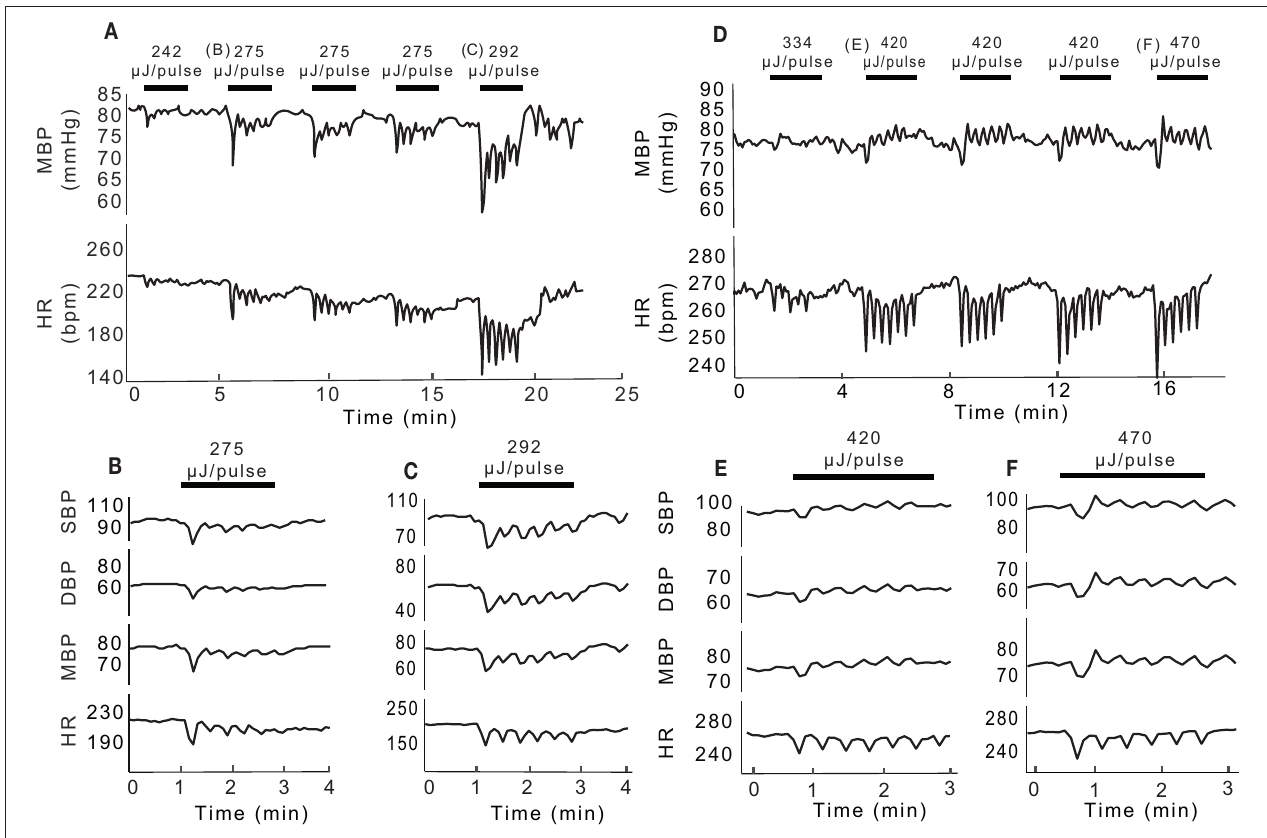
FIGURE 2 | Changes in BP and HR evoked by unilateral pulsed IR directed at PC. (A) Shows example mean BP (mmHg) and HR (bpm) responses recorded in one rat at different IR radiant exposures. Black bars indicate the 2-min IR stimulus intervals with the radiant energy at each interval noted above (242 to 292 µ J/pulse). The initial observable response (threshold) occurred at 242 µ J/pulse. (B,C) Show single events at 275 and 292 µ J/pulse, respectively and the corresponding changes in systolic (SBP), diastolic (DBP), and mean (MBP) pressures as well as changes in HR. (D) Shows responses recorded in another rat at different radiant exposures (292 to 470 µ J/pulse) with the observed threshold at 420 µ J/pulse. (E,F) Show single events at 420 and 470 µ J/pulse, respectively, and the corresponding changes in SBP, DBP, MBP, and